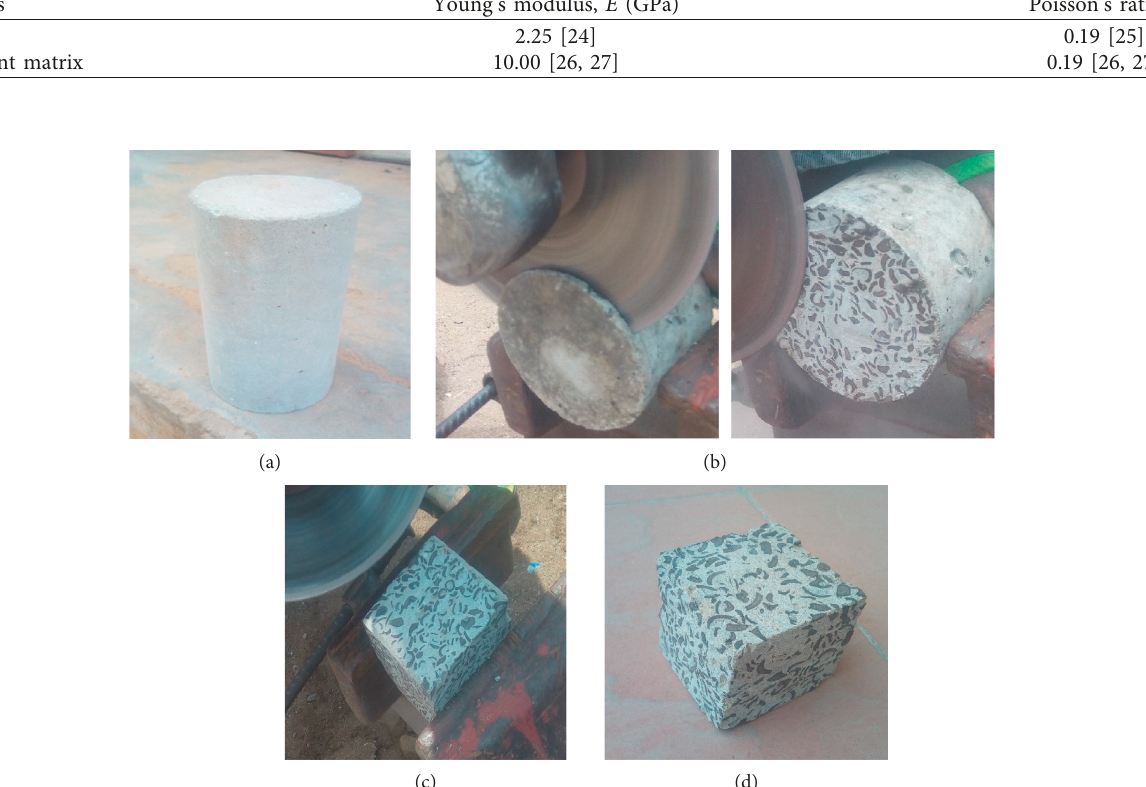
Figure 2: Process of obtaining RVE: (a) whole sample, (b) cutting of the test specimen, (c) grinding and smoothing of faces, and (d) cubic